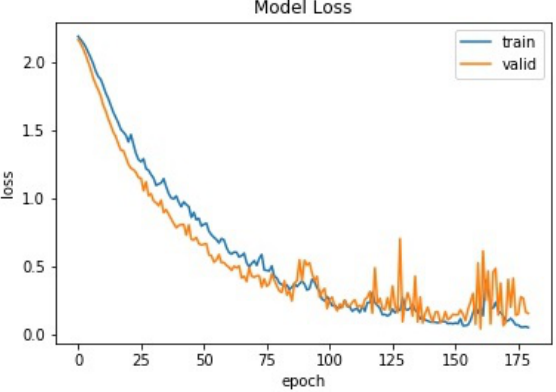
Figure 15. CNN training and validating curves based on loss.